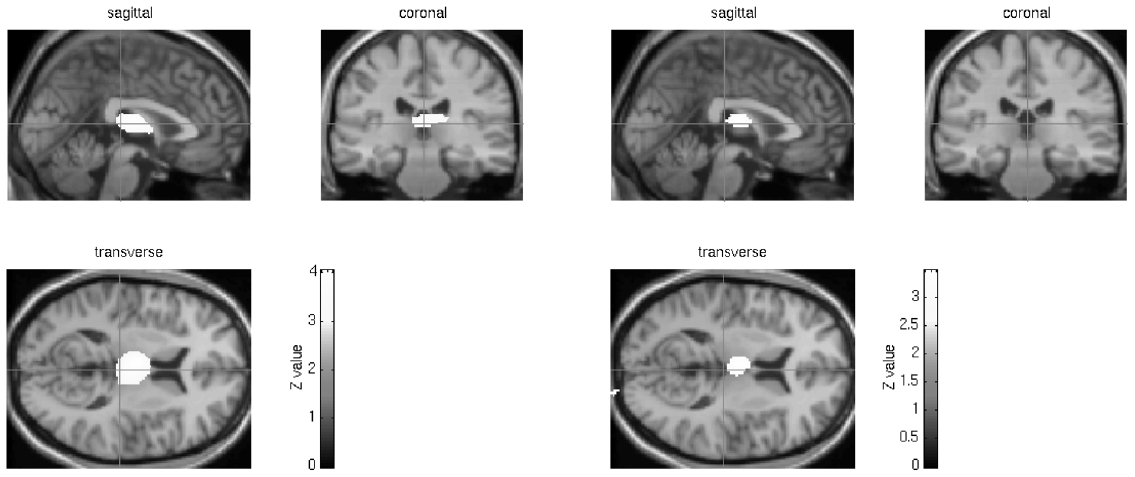
Fig. 6. SPM results comparing patients with aneurysms at sites other than ACoA with control subjects; Fig. 6(a)(left): whole brain normalisation, Fig. 6(b)(right): cerebellar normalisation. The figures show selected orthogonal slices through the corresponding statistical parametric map superimposed on a standard T1 weighted MR image, which is displayed in Talairach